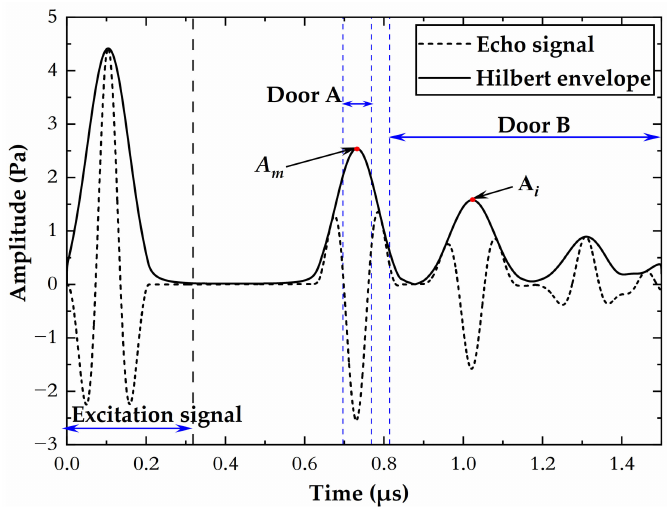
Figure 5. The original pulse-echo signal and its envelope at the interface of multilayer